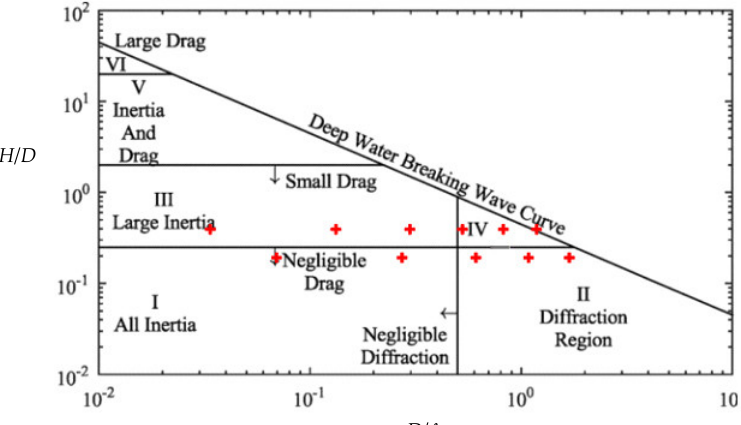
Figure 2. Different wave force regimes exposed to the WEC rotor [10]; (+) represents the WEC rotors exposed to different wave frequencies in the investigation.